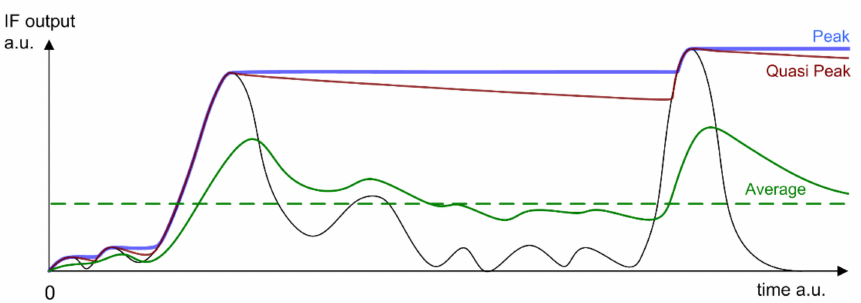
Figure 2. Sketch of detector operating principle on an ideal IF (Intermediate Filter) output, i.e., band-passed portion of the incoming signal: peak (blue), quasi peak (brown), average (green); for the average detector both the time varying trace tracking instantaneous average value and the conventional mean value at the end of the dwell time are shown—solid and dashed, respectively. Time and amplitude in arbitrary units